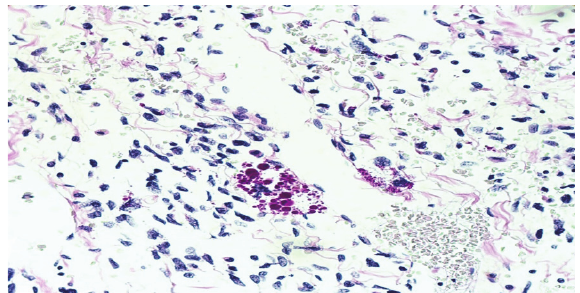
Figure 6: PAS positive hyaline globules (high power, H&E).